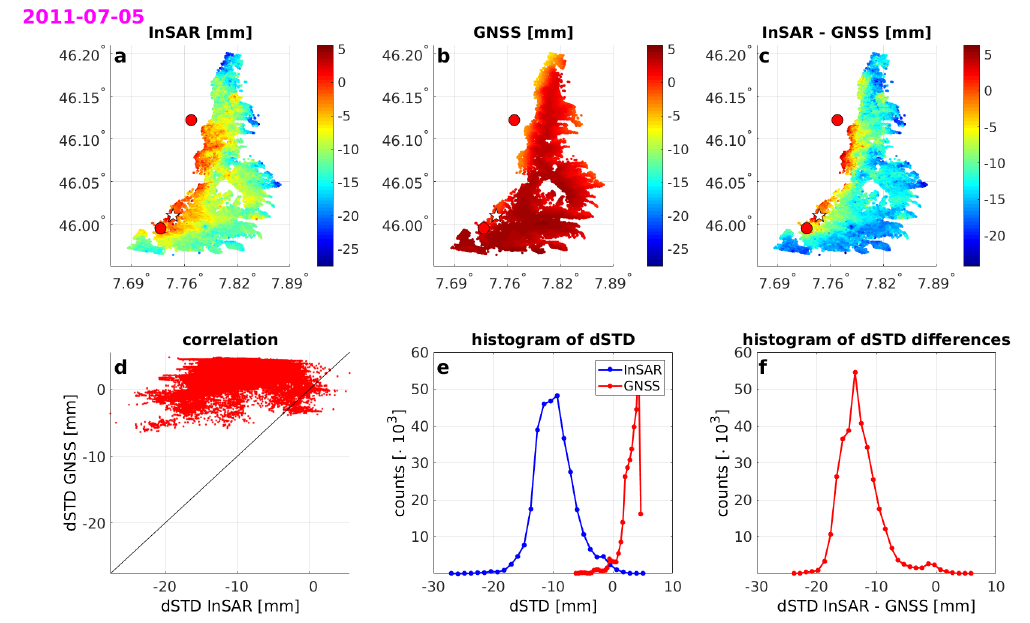
Figure 8. Comparison between InSAR and GNSS for a day with the worst agreement (5 July 2011). The plots show ( a ) InSAR-based dSTD s for all PS points; ( b ) GNSS-based dSTD s for all PS points; ( c ) the differences between ( a , b ); ( d ) the correlation between techniques; ( e ) the histograms of dSTD values for both techniques and ( f ) the histogram of differences dSTD InSAR − dSTD GNSS . The white star indicates the reference point and red dots the GNSS stations within the research area.